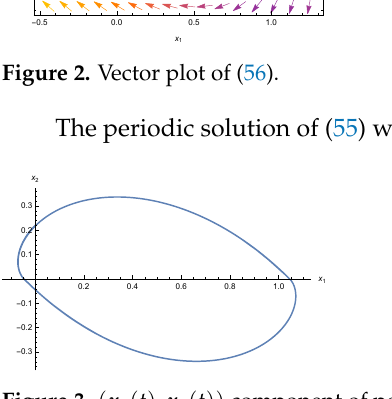
Figure 3. ( x 1 ( t ) , x 2 ( t )) component of periodic solution of (55) with ε = 0.01.